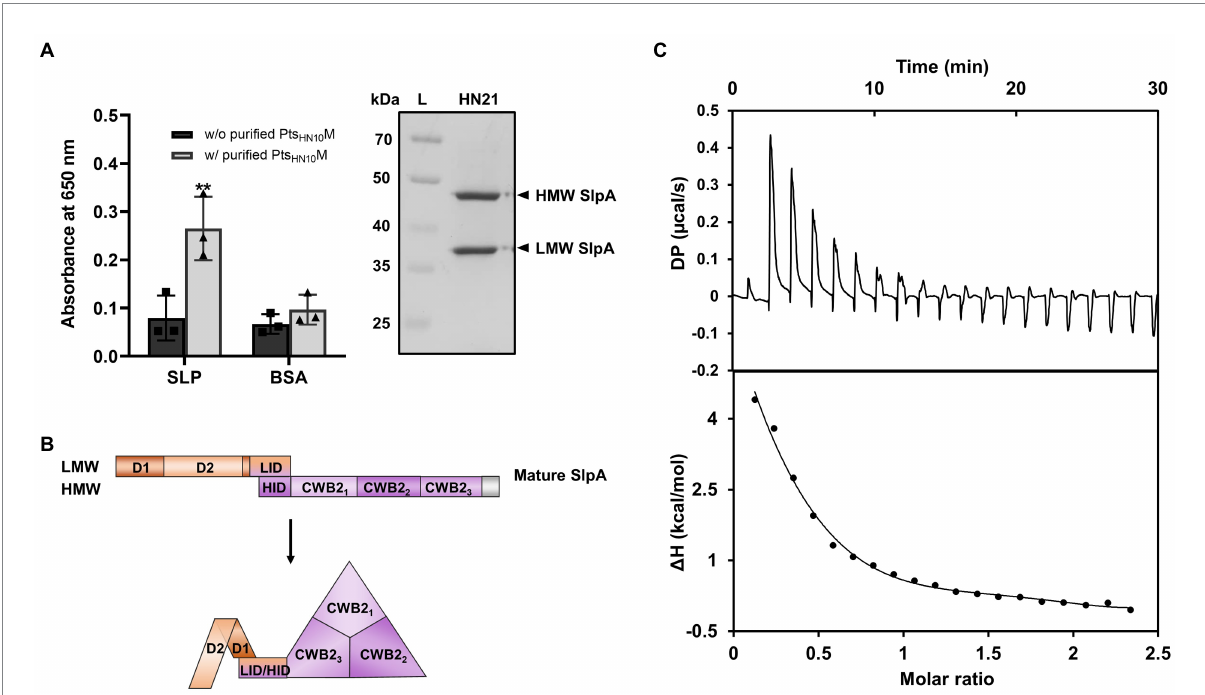
FIGURE 5 Binding of Pts HN10 M to SlpA of C. difficile . [ (A) , left] ELISA results of purified His 6 -Pts HN10 M and low-pH glycine extracted SLP fractions were visualized at an absorbance of 650 nm. The graph shows the mean and standard deviation from three replicates. The asterisk indicates a significant difference in data ( p < 0.01). [ (A) , right] SDS-PAGE reveals the SLP fractions extracted from C. difficile strain HN21. The bands of high-molecular weight (HMW) and low-molecular weight (LMW) SlpA are indicated. L, protein ladder. (B) Schematic representation of the mature SlpA in C. difficile . The three CWB2 domains of the HMW form a triangle structure and LMW, especially the D2 domain, is exposed on the exterior of the core CWB2 trimeric complex (Lanzoni-Mangutchi et al., 2022). (C) Isothermal titration calorimetry analysis shows thermodynamic parameters of binding between purified Pts HN10 M and LMW SlpA. The upper panel is the titration raw data for the injection of 0.2–19.8 μ l aliquots of 1–1.25 mM ligand solution into 110 μ M of protein. The lower panel is the integrated heats of binding obtained from the raw data. The solid line in the bottom panels represent the best curve fit using the one set of sites